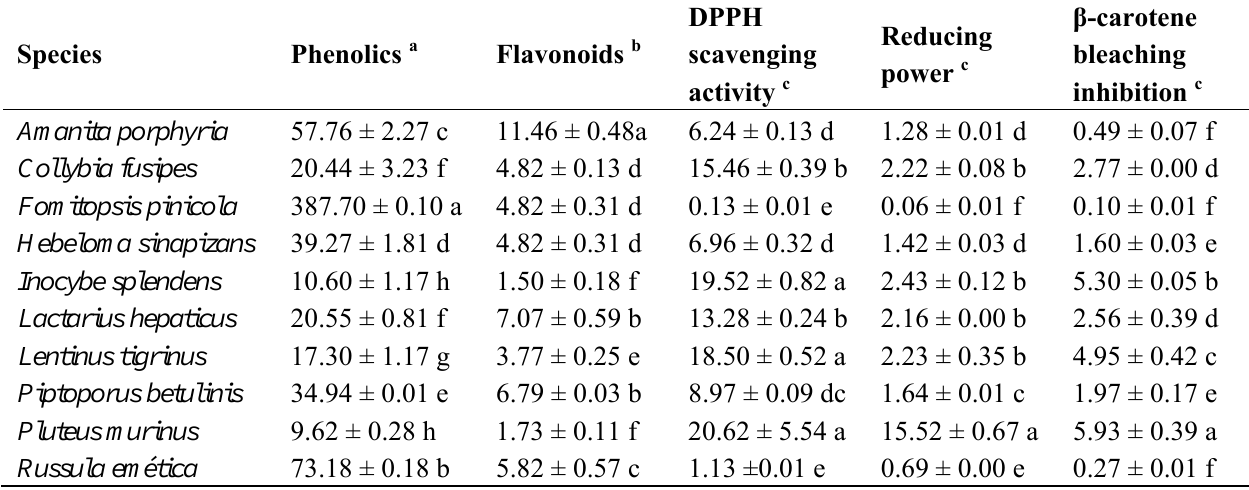
Table 4. Biomolecules (phenolics and flavonoids) with antioxidant value and antioxidant activity EC 50